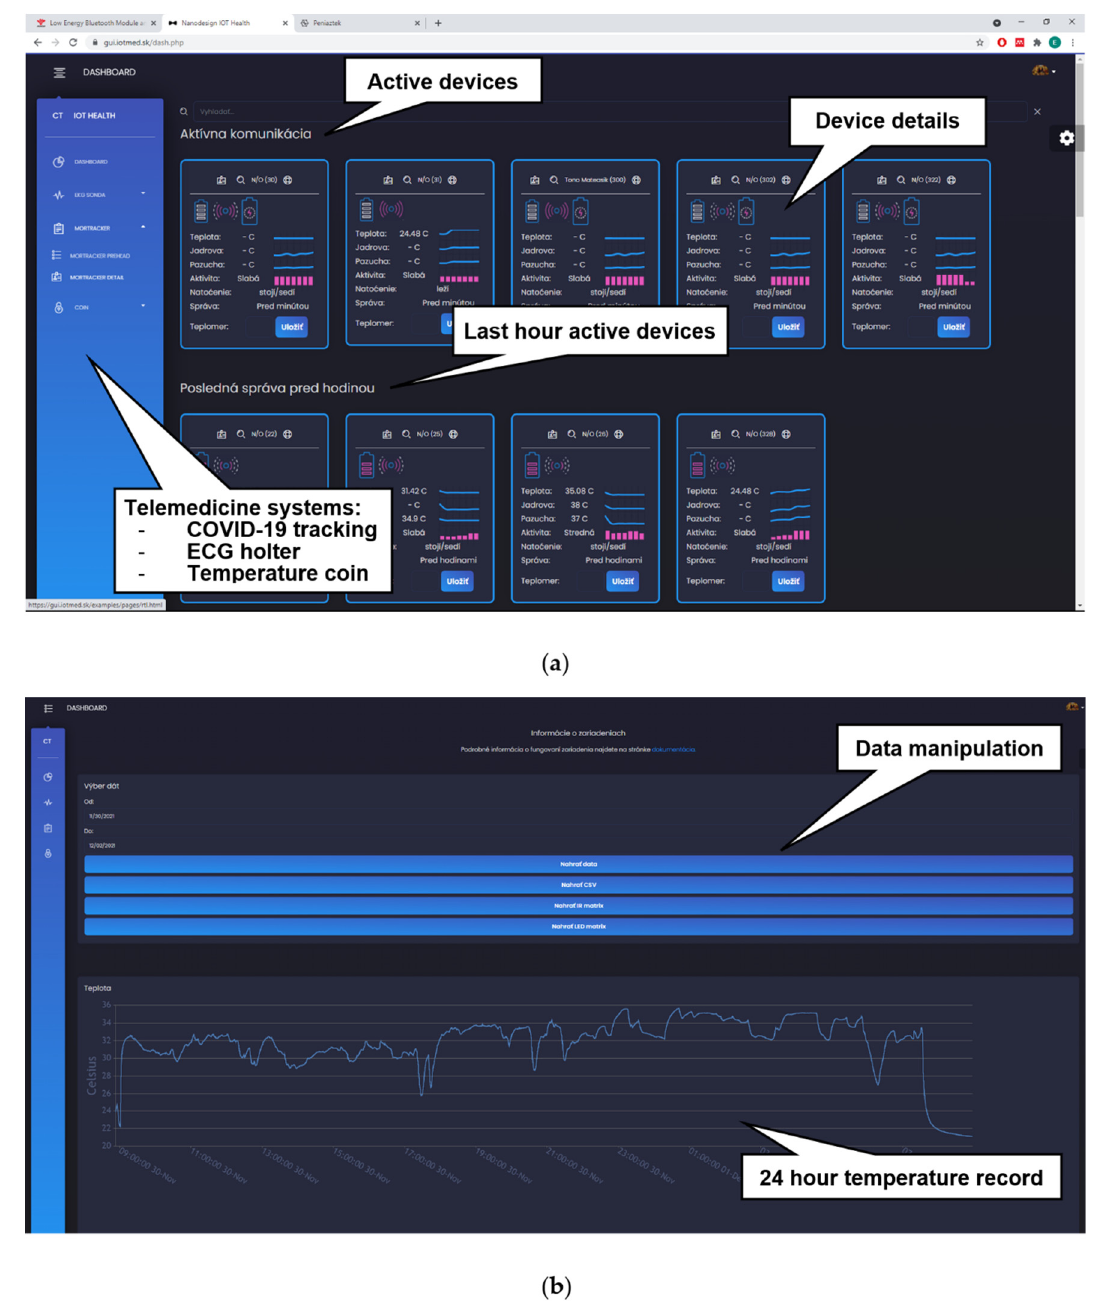
Figure 7. Web access to the back-end: ( a ) IOT Health system with displayed active devices; ( b ) daily graph of the measured peripheral temperature.